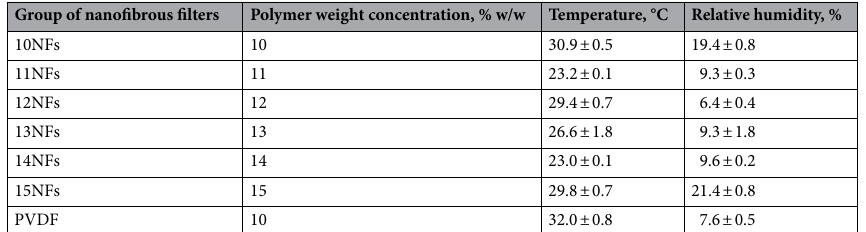
Group of nanofibrous